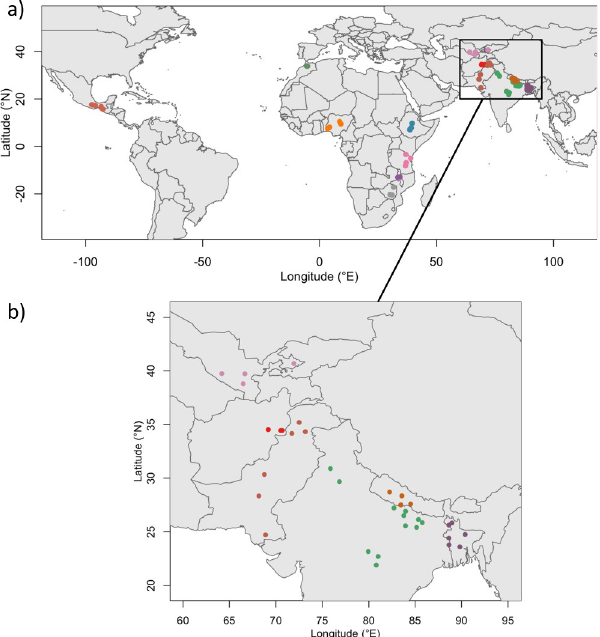
Fig 1. Map of the study areas with emphasis on Asia. The colour represents the different villages within country cohorts, in total 70 distributed across 13 countries (Mexico, Morocco, Ethiopia, Tanzania, Malawi, Nigeria, Zimbabwe, Afghanistan, Pakistan, Uzbekistan, Bangladesh, Nepal, and India). Village distribution by region is provided in Table 3.